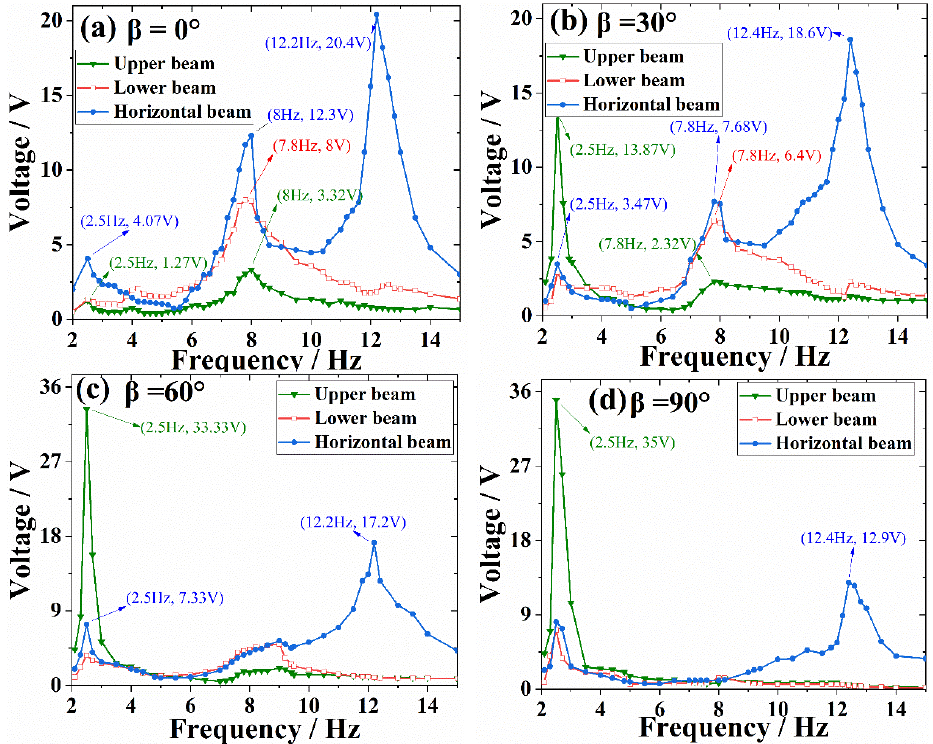
Figure 10. Open-circuit voltage versus frequency under horizontal excitation with different β .